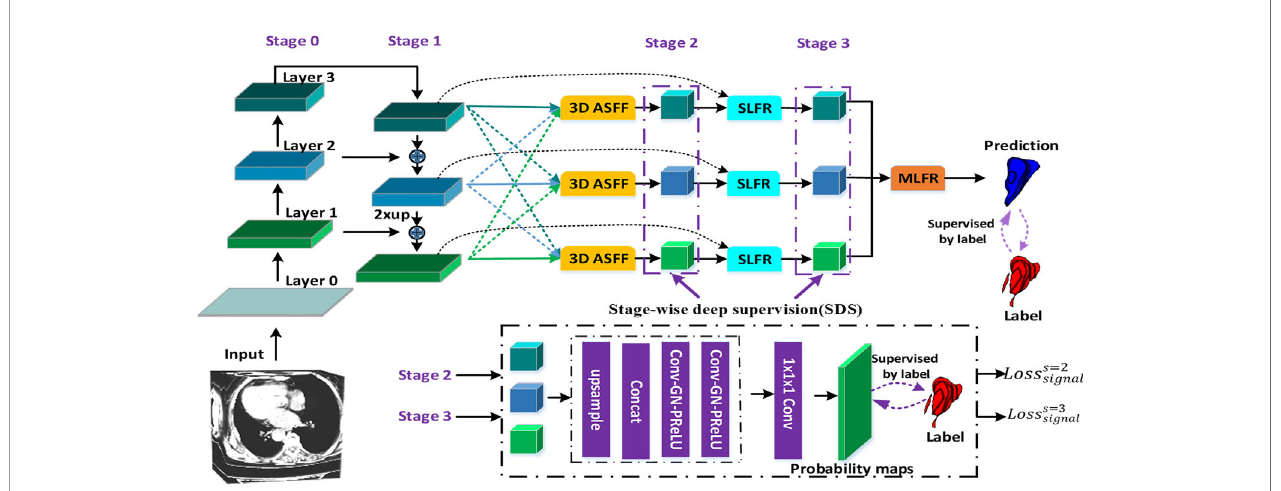
FIGURE 1 | The fl owchart of our gastric tumor segmentation network equipped with multi-type feature enhancement modules (3D ASFF, 3D adaptive spatial feature fusion; SLFR, Single-level feature re fi nement; MLFR, Multi-level feature re fi